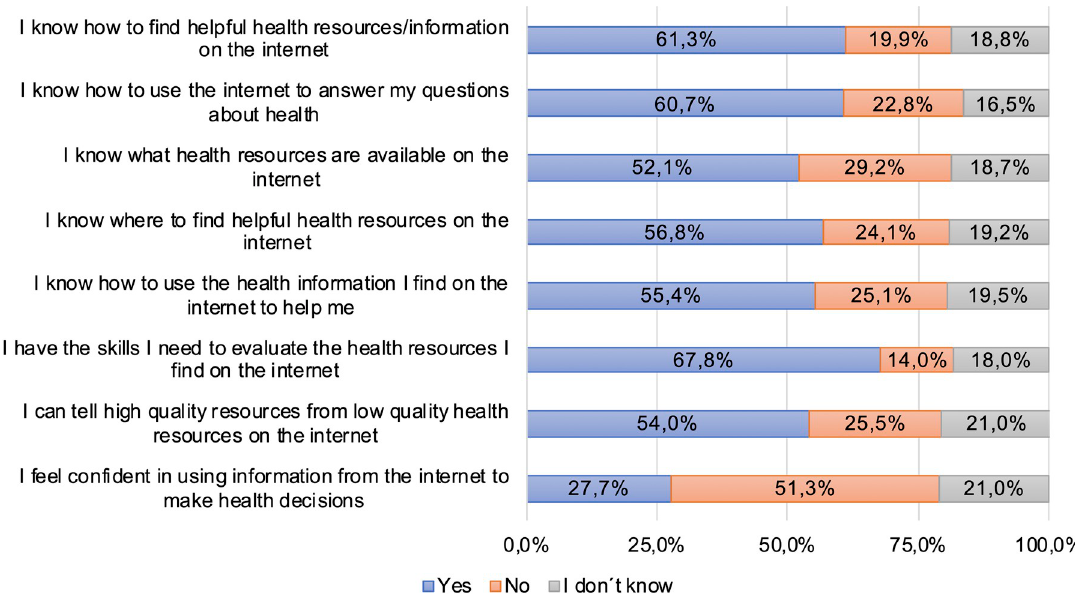
Fig 5. Results of the eHealth Literacy Scale